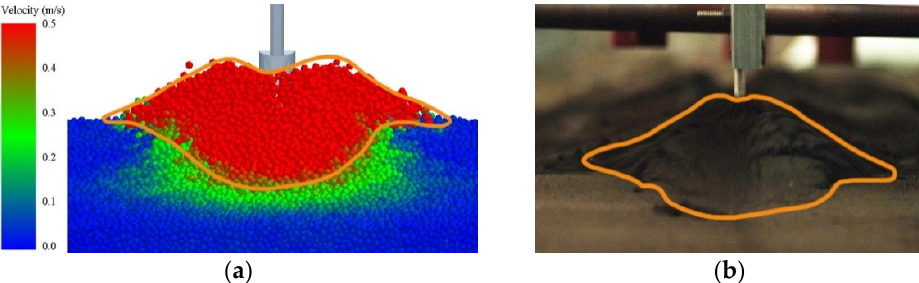
Figure 20. Comparison of soil particle movement during Su 3 operation predicted by the discrete element test model with the indoor soil bin test at 80 mm operation depth and 10 km h − 1 velocity. ( a ) Discrete element test; ( b ) Indoor soil bin test.